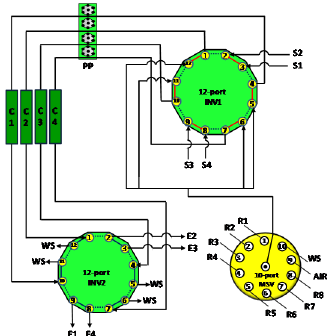
Figure 10. Schematic deposition of a flow system for four-sample simultaneous processing [64,79]. SV: selection valve.